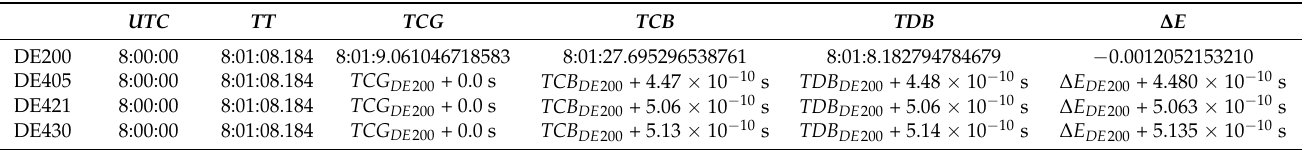
Table 1. Comparison of Einstein delay at satellite at observation start time. The satellite began to observe the Crab pulsar at 8 a.m. UTC time on 17 November